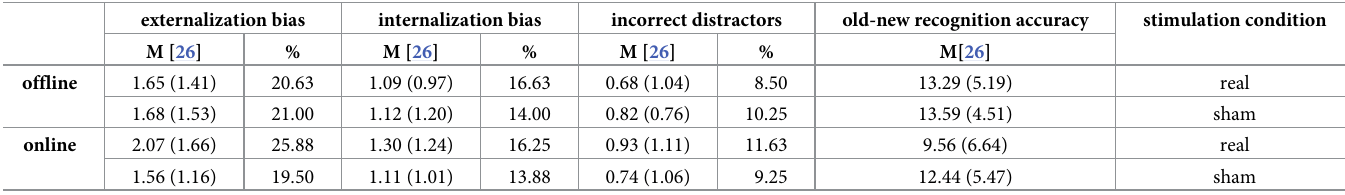
Table 3. Means and standard deviations of absolute errors as well as means of the error rates in percent in the Hear-Imagine